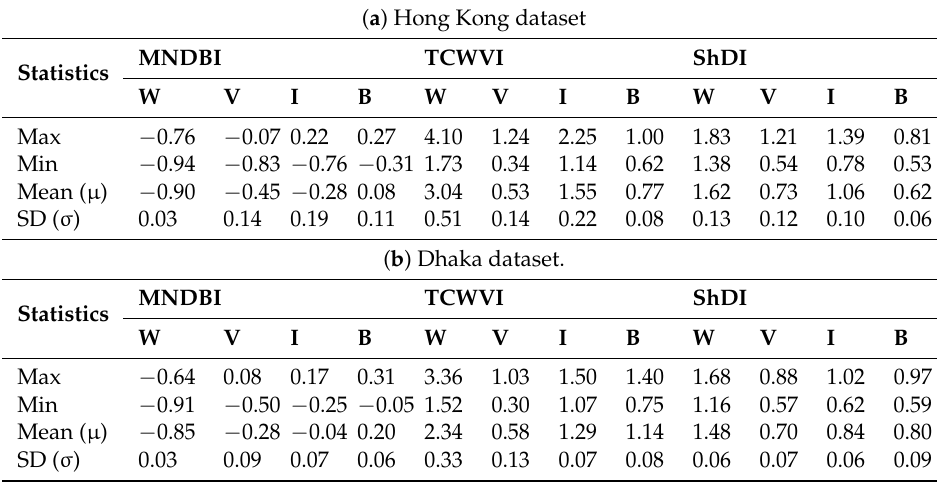
Figure 8. Ground reflectance of different land cover types identified by the MNDBI in the Dhaka dataset. Table 2. Statistics of different land cover types identified by the proposed indices.